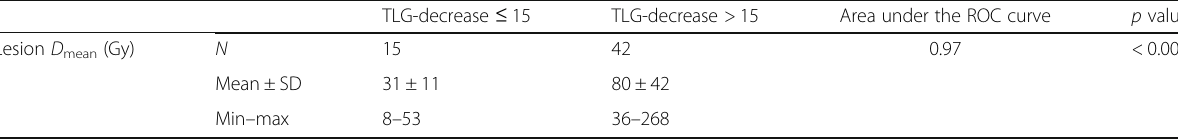
Table 3 Results of the univariate analysis for predicting a TLG-decrease of less than